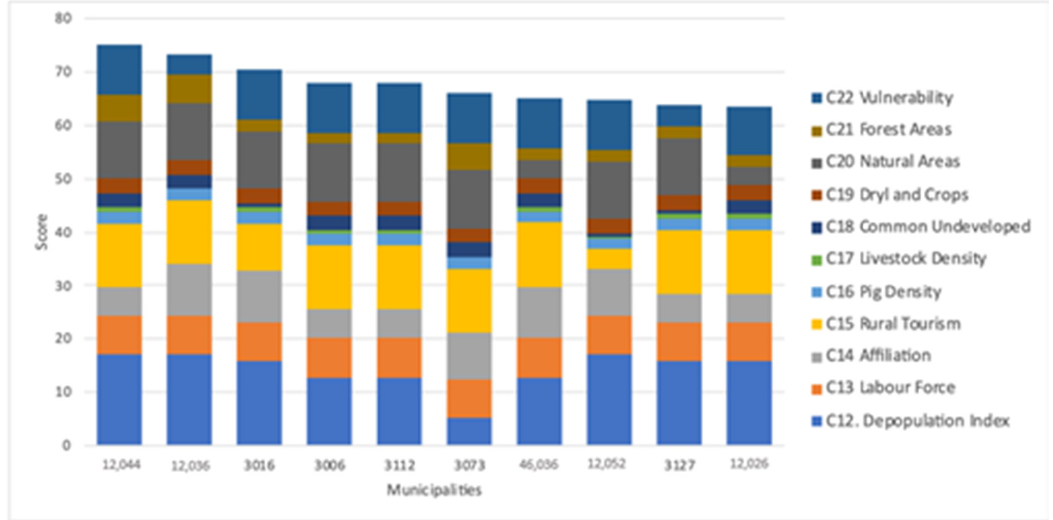
Figure 15. Contribution graph of the municipalities which are the best to establish new farms.